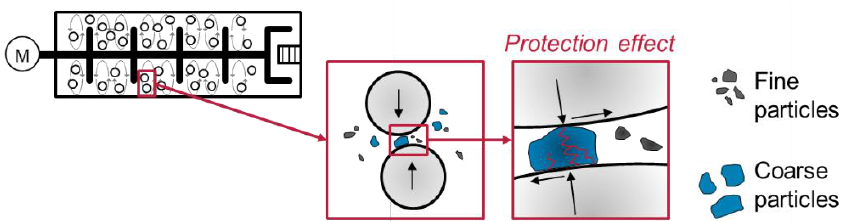
Figure 9. Schematic representation of the protection effect occurring during stirred media milling of mixtures with individual components of different sizes.